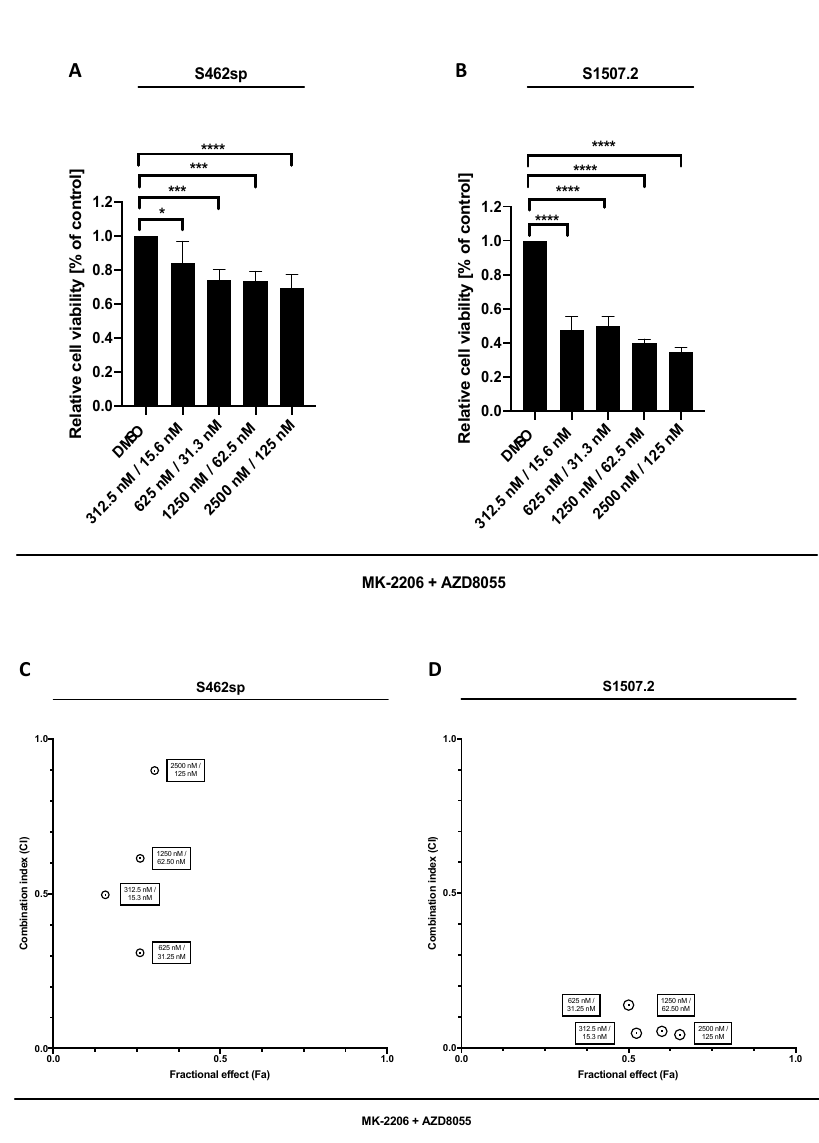
Figure 2. MPNST cell viability after combinatory treatment with MK-2206 and AZD8055 in vitro. MPNST cells were seeded in a 96-well-plate at a density of 5000 cells per well. Relative cell viability (normalised to control) of S462sp ( A ) and S1507.2 ( B ) cells under varying concentrations of combined MK-2206 and AZD8055 treatment was measured in an XTT assay after 72 h. The mean values with standard deviation are shown. Statistical significance was analysed with a one-way ANOVA with Dunnett’s multiple comparisons test and compared to the vehicle substance dimethyl sulfoxide (DMSO) (* p ≤ 0.05; *** p ≤ 0.001; **** p ≤ 0.0001). Combination indices (CI) were calculated based on the XTT assay (Figures 1 and 2) according to the Chou and Talalay method and plotted against their respective fractional e ff ect (Fa) on cell viability (very strong synergism CI < 0.1; strong synergism CI 0.1–0.3; synergism CI 0.3–0.7; moderate synergism CI 0.7–0.85; slight synergism CI 0.85–0.90; nearly additive CI 0.9–1.10; antagonistic CI > 1.1). The data for dual targeting with MK-2206 and AZD8055 on S462sp ( C ) and S1507.2 ( D ), compared to single treatment, are